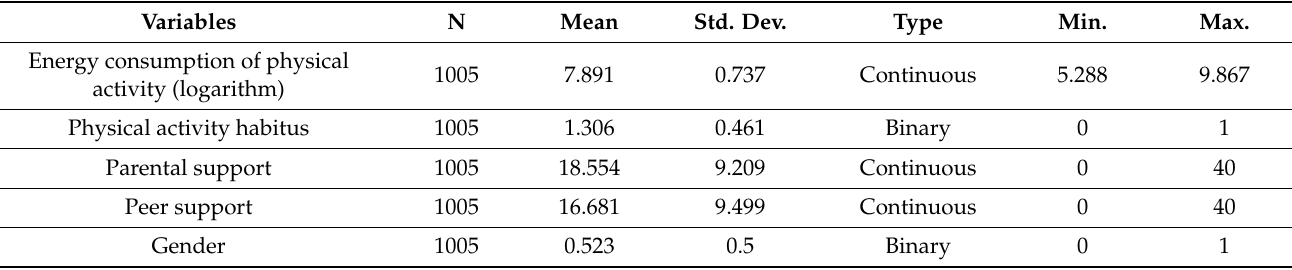
Table 2. Descriptive statistics of the